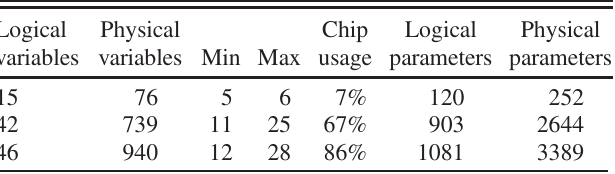
TABLE I. Main characteristics of the different embeddings used here, for each of the fully connected graphs. All embeddings were generated by the find_embedding [75] heuristic pro- vided by D-Wave ’ s API. The table includes information about the minimum (Min) and maximum (Max) subgraph size, the per- centage of qubits used relative to those available (Chip usage), and the total number of parameters for the logical and physical